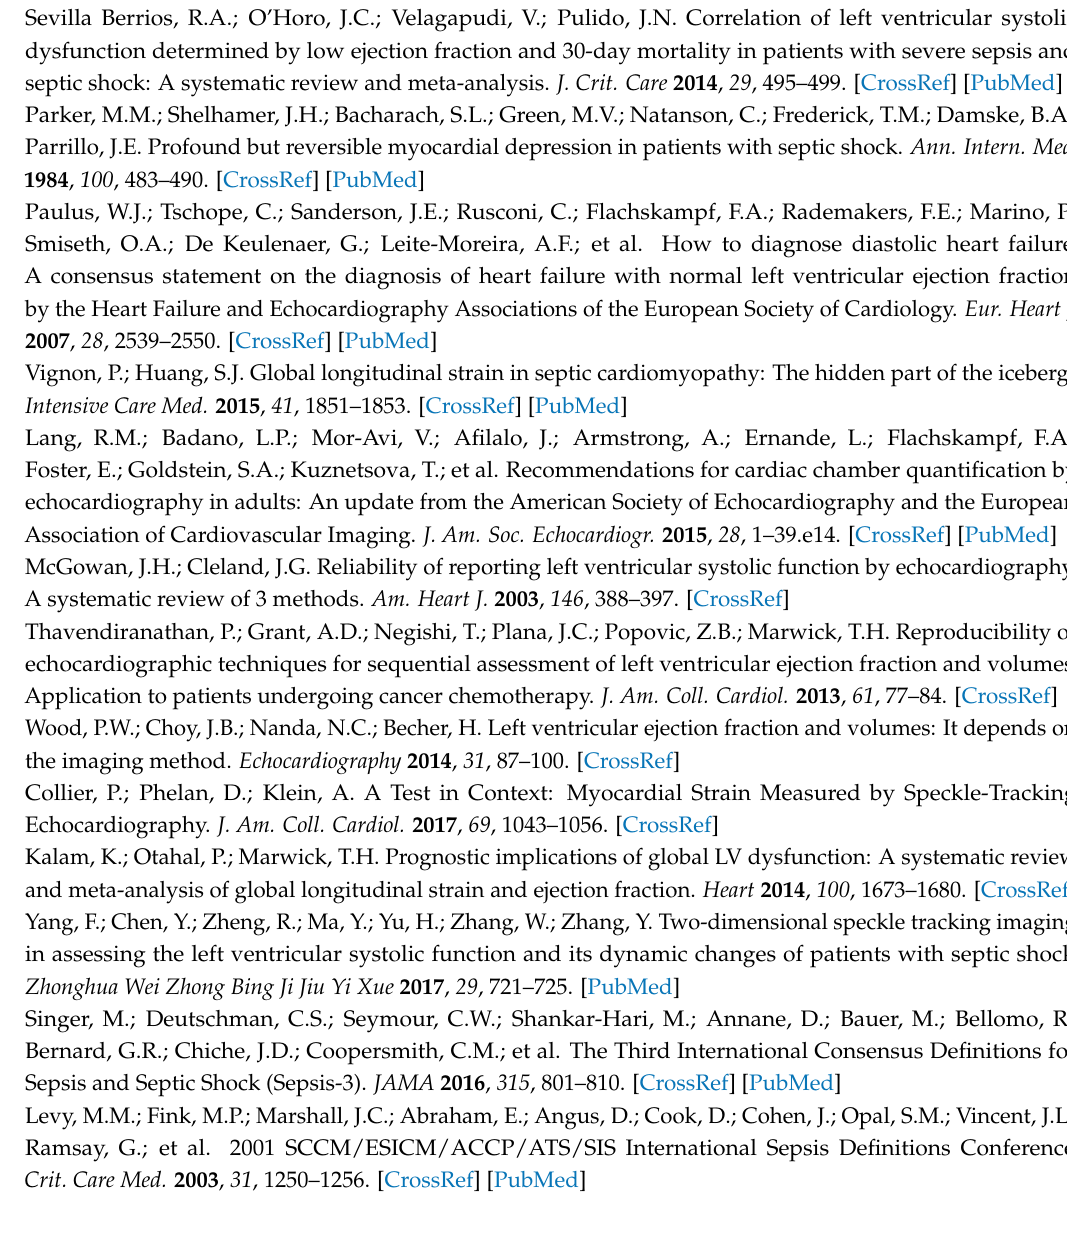
Table S1: Description of studies including design, inclusion criteria, subjects and imaging platforms/software, Table S2: Exclusion Criteria, Table S3: